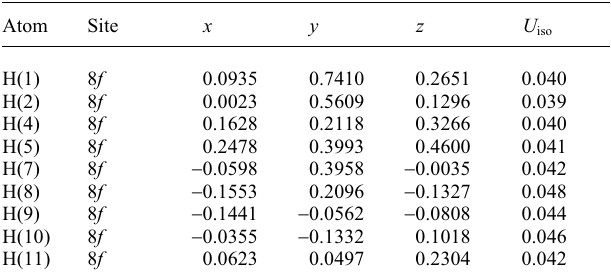
Table 2. Atomic coordinates and displacement parameters (in Å 2 )